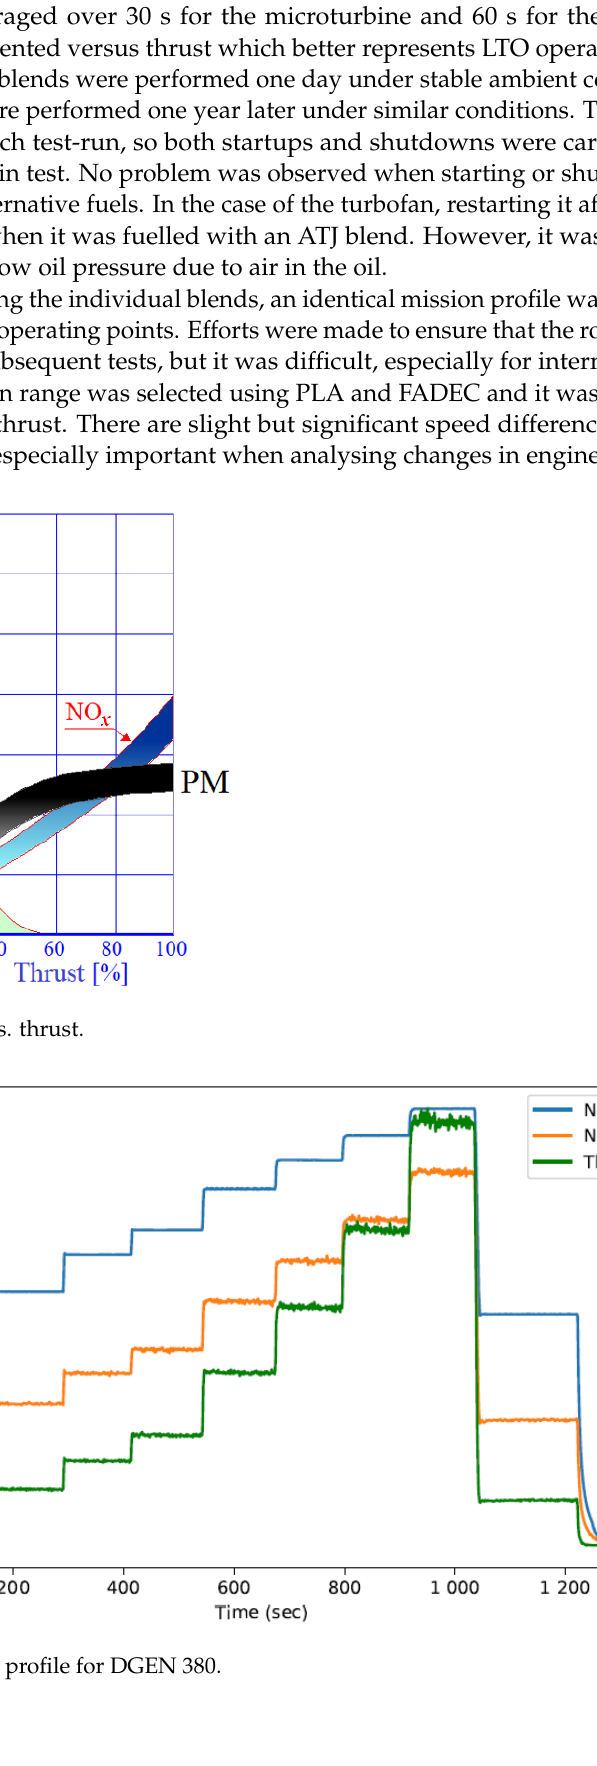
Figure 10. Engine test profile for DGEN 380.